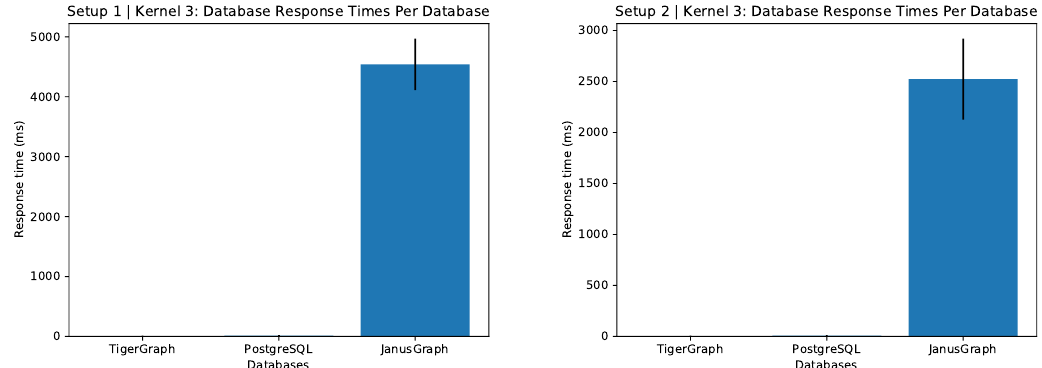
Figure 4. Database response times (which is below 10ms for TigerGraph and PostgreSQL) using the medical response dataset for setup 1 and 2 for the kernel: “Long Response Count”. The error bars display standard